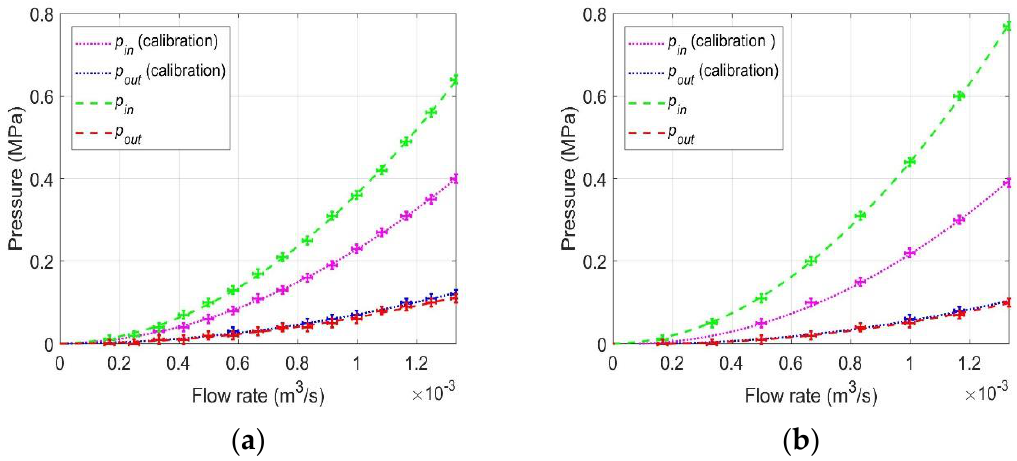
Figure 8. Pump inlet and outlet pressure measured in the circuit during the calibration tests and the tests with the mock-ups equipped with the MCs and nylon cavity ( a ) and RR ( b ). The error bars on the measured data are reported, together with the respective fits for convenience.